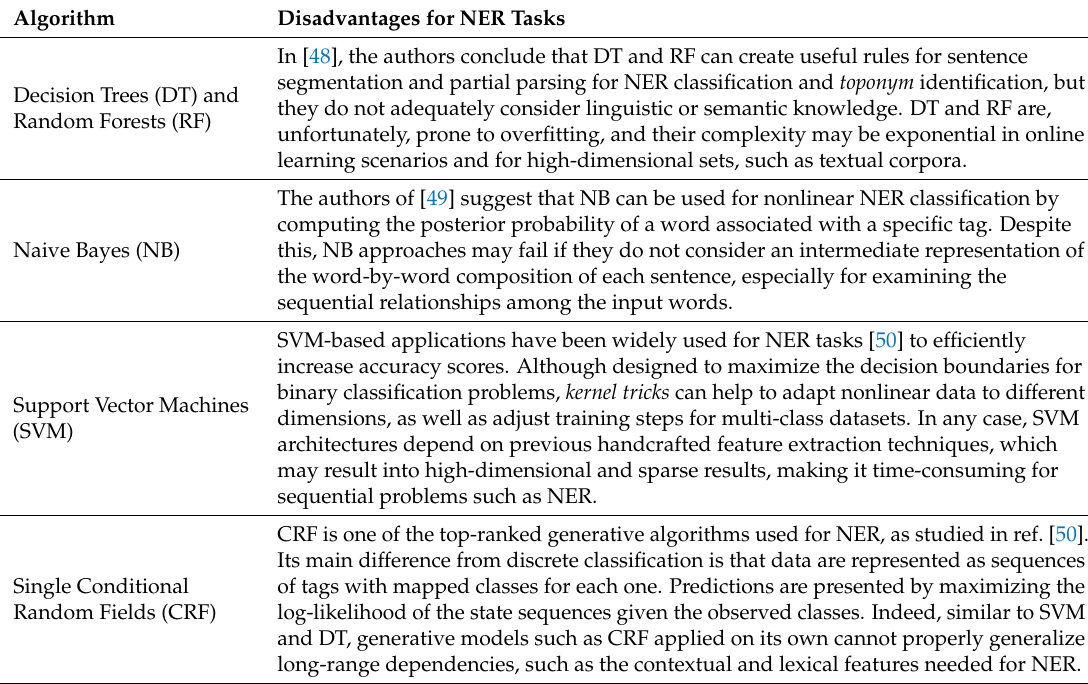
Table 2. Disadvantages of algorithms employed for NER